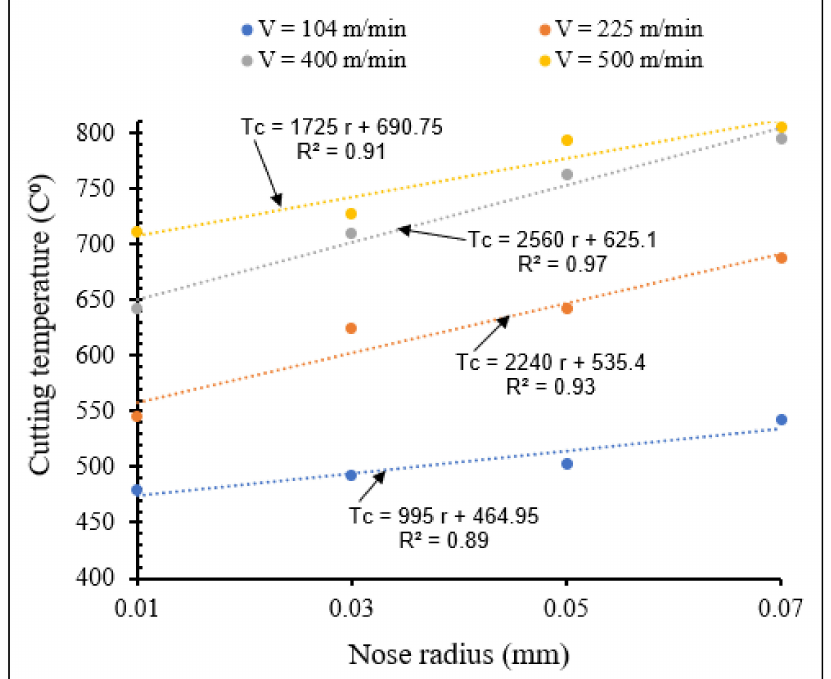
Figure 16. Variation of maximum temperature with small tool nose radius for different cutting speeds at f = 0.1 mm/rev, γ = 5 ◦ .